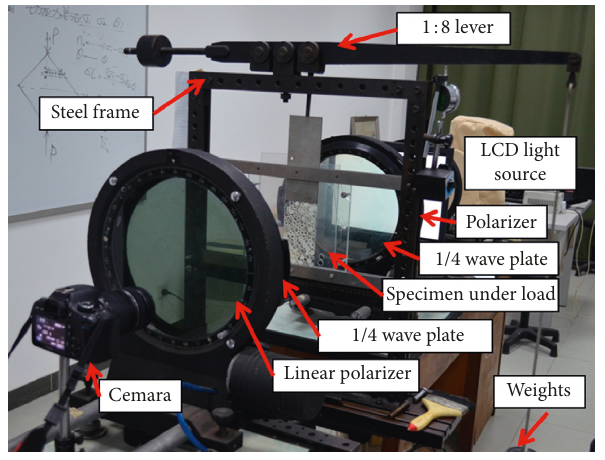
Figure 2: Schematic of polariscope.